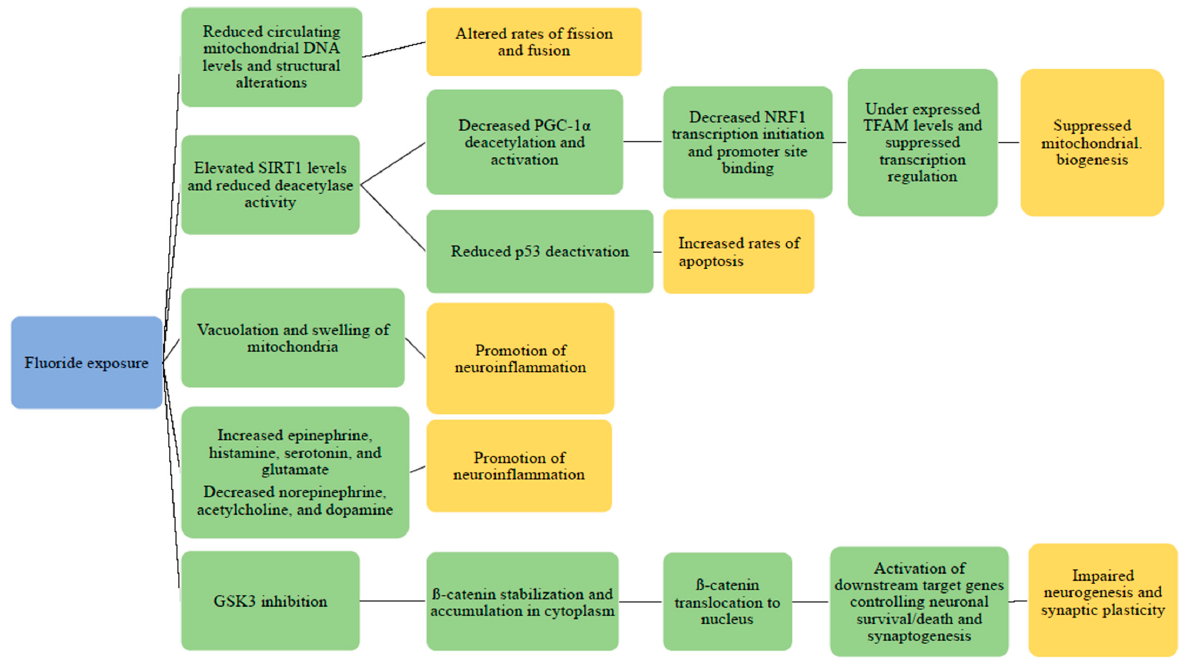
Figure 1. Potential mechanisms of fluoride-based mitochondrial damage. The proposed impact of fluoride exposure is detailed regarding the PGC-1 α /NRF1/TFAM signaling pathway, p53 deactivation, alterations in neurotransmitter levels, and fission/fusion levels in mitochondria. Fluoride exposure is highlighted in blue; mechanisms of mitochondrial damage are highlighted in green, and outcomes are highlighted in yellow.